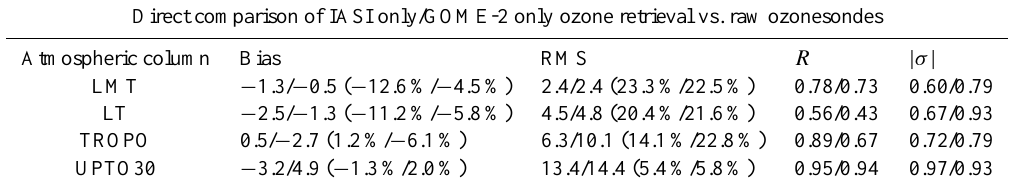
Table 5. Direct comparison of IASI only (left) and GOME-2 only (right) ozone retrievals against raw ozonesonde measurements. The same as Table 3 but without smoothing ozonesonde profiles with retrieval averaging kernels.